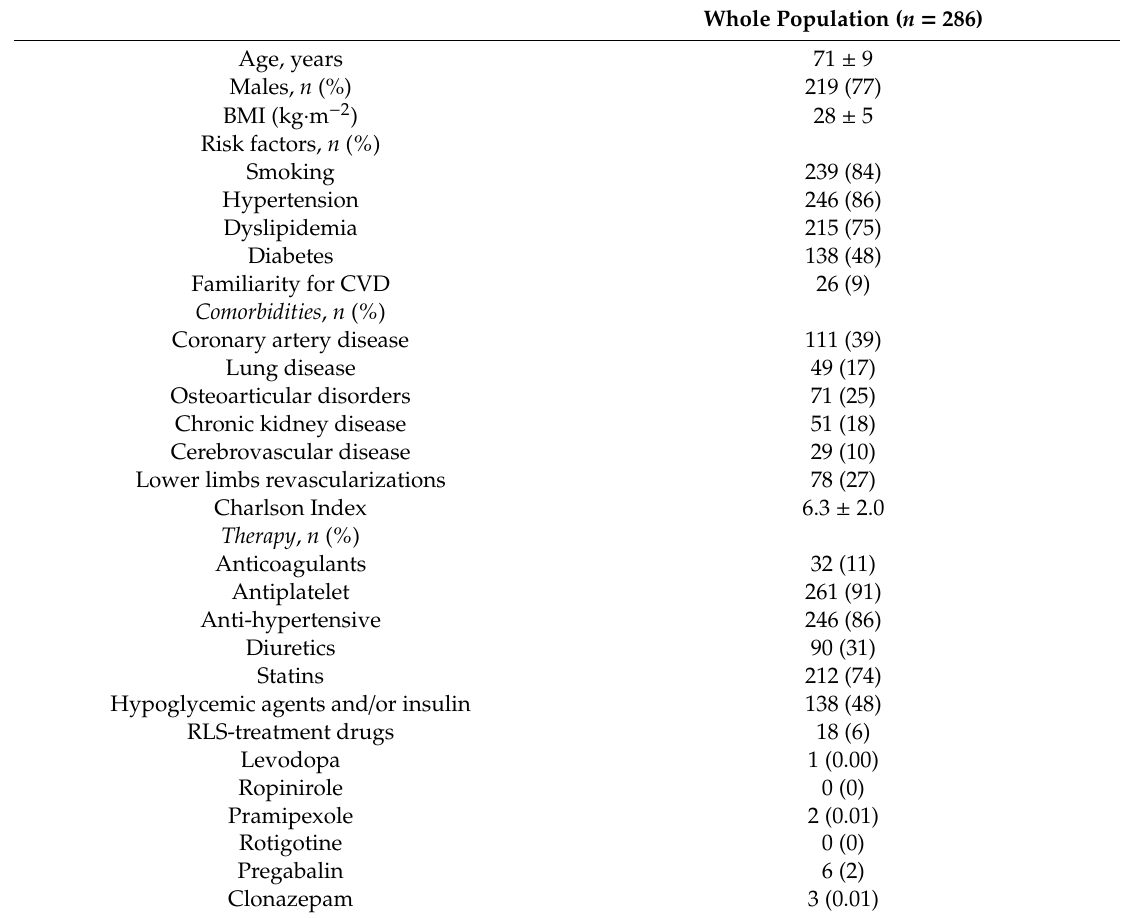
Table 1. Characteristics of the population included in the